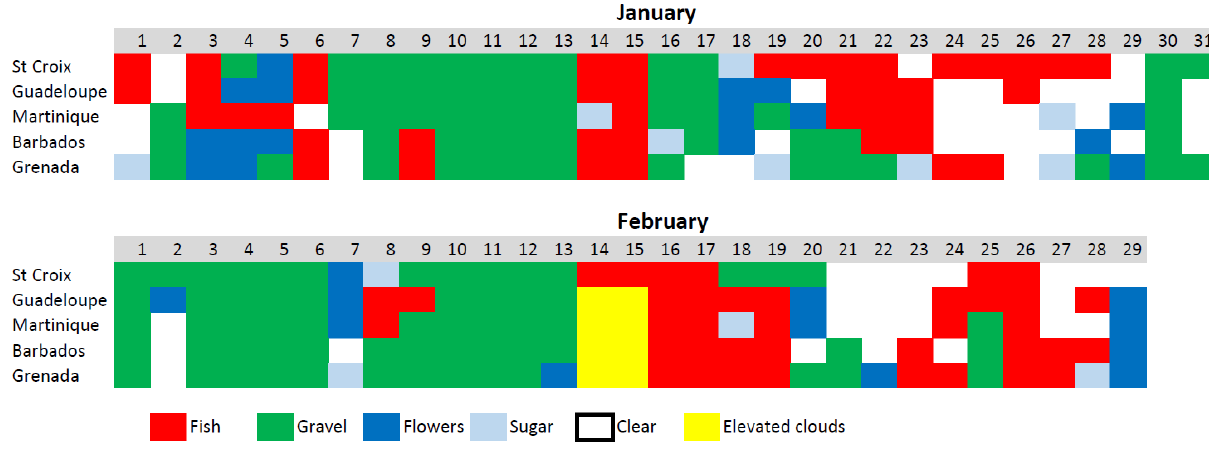
Figure 11. Cloud type classification performed for each of the five sites in January and February